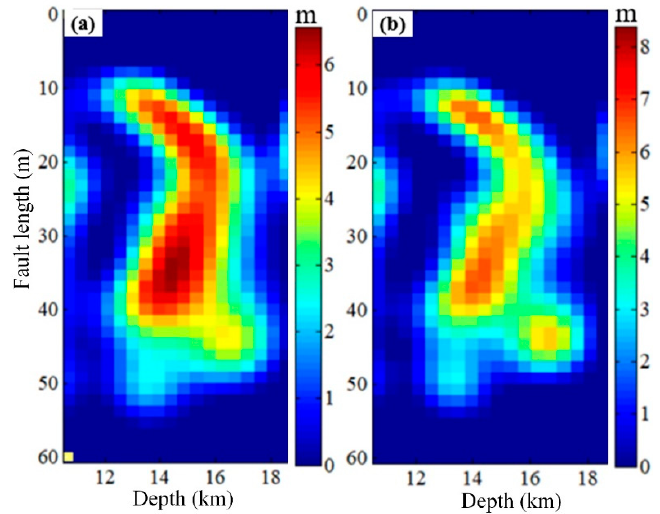
Figure 5. The main fault slip distribution. ( a ) and ( b ) are obtained by variable slip inversion based on the 3D deformation data sets and the line-of-sight (LOS) deformation data sets, respectively.